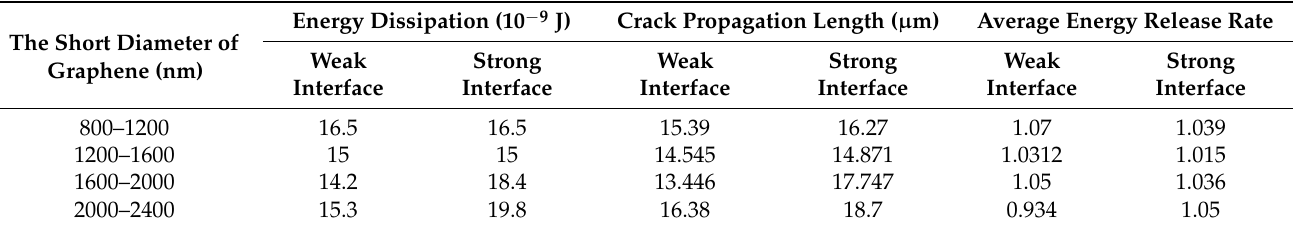
Figure 3. The simulation results of crack propagation paths with different long diameters when the short diameter of graphene is 10–50 nm. Table 4. The calculation results of microscopic models with different long diameters when the short diameter of graphene is 10–50 nm.